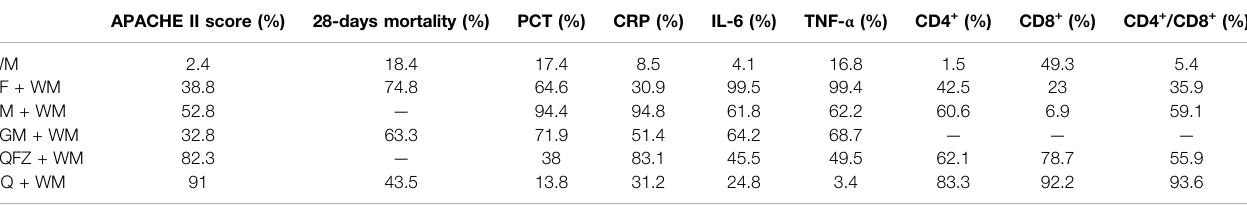
TABLE 12 | MDs with 95% CIs of APACHE II score. Signi fi cant effects are printed in bold. SQFZ + WM p = 0.29, − 1.10 ( − 2.58, 0.51) SM + WM p = 0.16, I 2 =